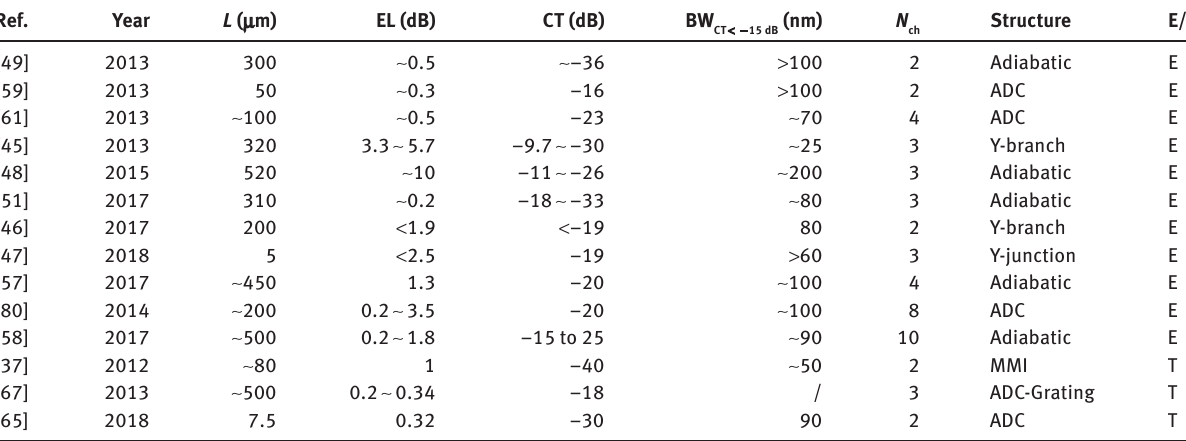
Table 1: Summary of the mode (de)multiplexers reported.